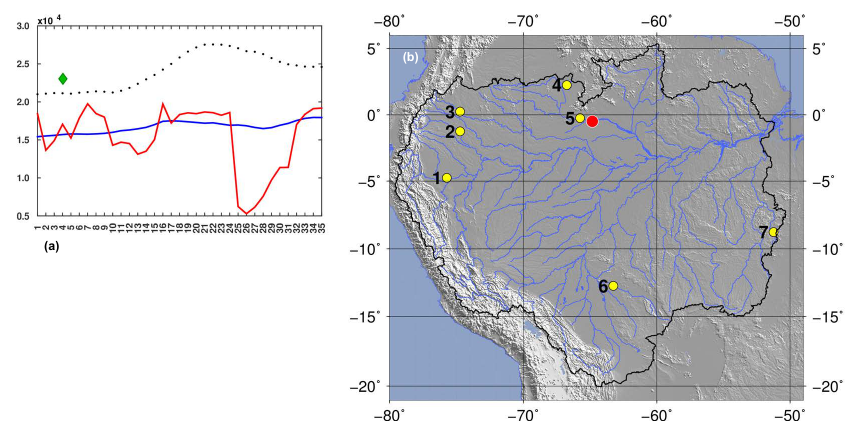
Figure 9. (a) Same as Fig. 8, panel 5 but only over the 35 first days of simulation. (b) Location of all active ENVISAT VS on the 25th day of the assimilation (yellow circles) compared to the location of the Serrinha stations (red circle).